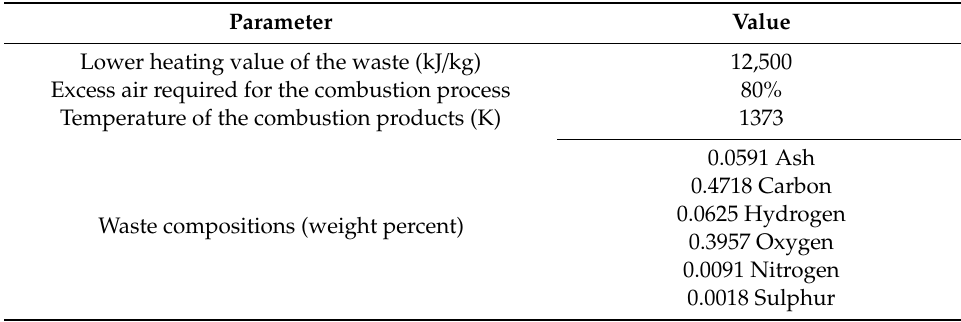
Table 1. Data utilized for municipal waste and waste incineration unit